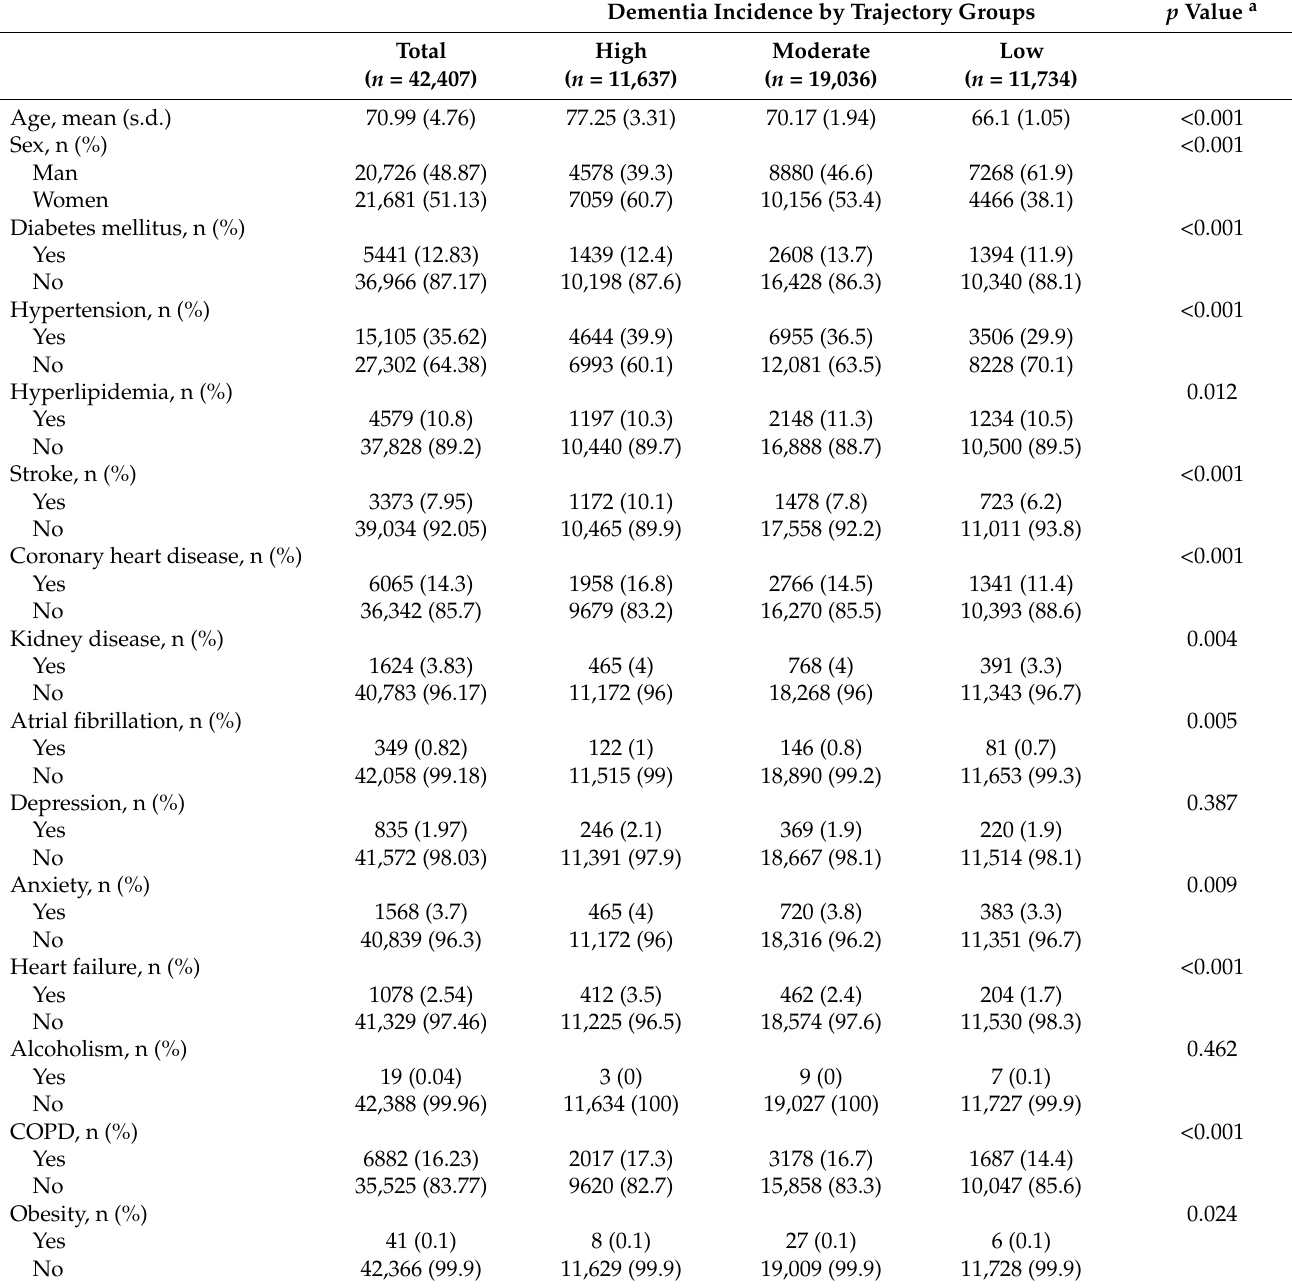
Table 1. Distribution of sample characteristics according to dementia trajectory groups. Dementia Incidence by Trajectory